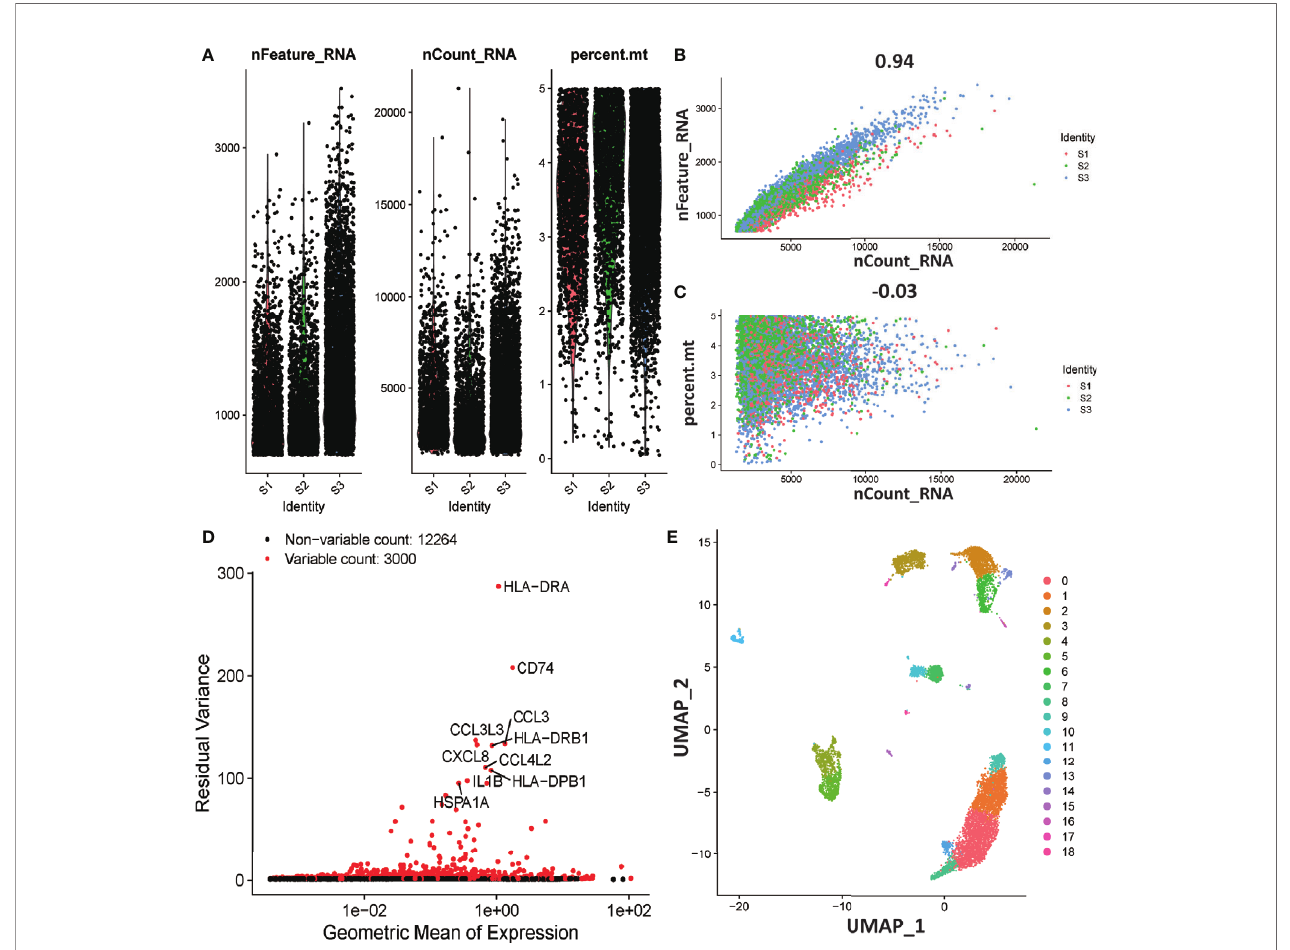
FIGURE 6 | Overview of preparations for cell type identi fi cation in deciduas. (A) Gene expression in each of the 9066 cells in three normal samples (S1, S2, and S3). The left graph shows the number of genes contained in each cell. The middle fi gure indicates the con fi dence level of the data. The right graph shows the percentage of mitochondria. The black dots represent cells. (B) The relevance of the number of UMI and the number of genes. The horizontal coordinate is the number of UMI of the cell and the vertical coordinate is the number of genes in the corresponding cell. The red, green and blue dots respectively represent samples S1, S2 and S3. (C) The relevance of the number of UMI and the percentage of mitochondria. The horizontal coordinate is the number of UMI of the cell and the vertical coordinate is the percentage of mitochondria. The red, green and blue dots respectively represent samples S1, S2 and S3. (D) The analytical map of genetic variability. Red dots represent variable counts and black dots represent non-variable counts. (E) The UMAP visualization maps of 19 cell clusters in the deciduas by single cell RNA sequencing